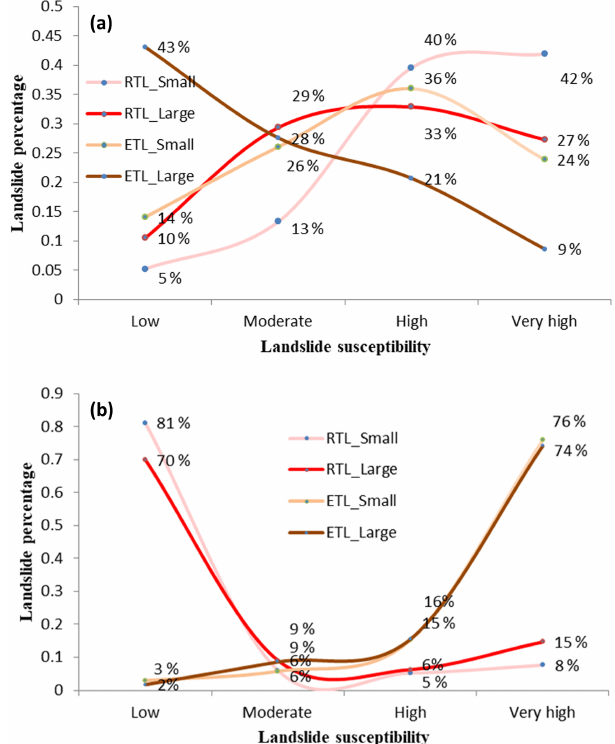
Figure 11. Cross validation of the landslide susceptibility maps. (a) The percentage of landslides in the various classes of the RTL susceptibility map. (b) The percentage of landslides in the various classes of the ETL susceptibility